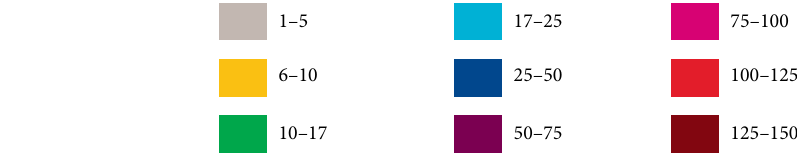
Figure 4: Locations of existing crossing points on national routes and the traffic flow in AADT at each